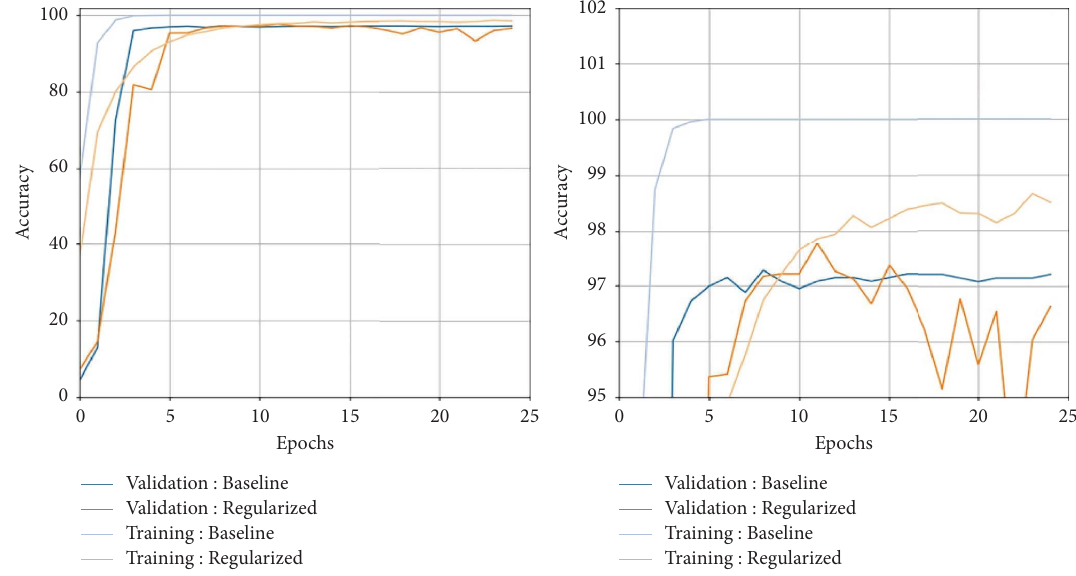
Figure 9: Baseline vs. regularized performance of model M1 on Odia character dataset. Table 9: Baseline models vs. regularized models in the Odia character database and the Odia numeral database.